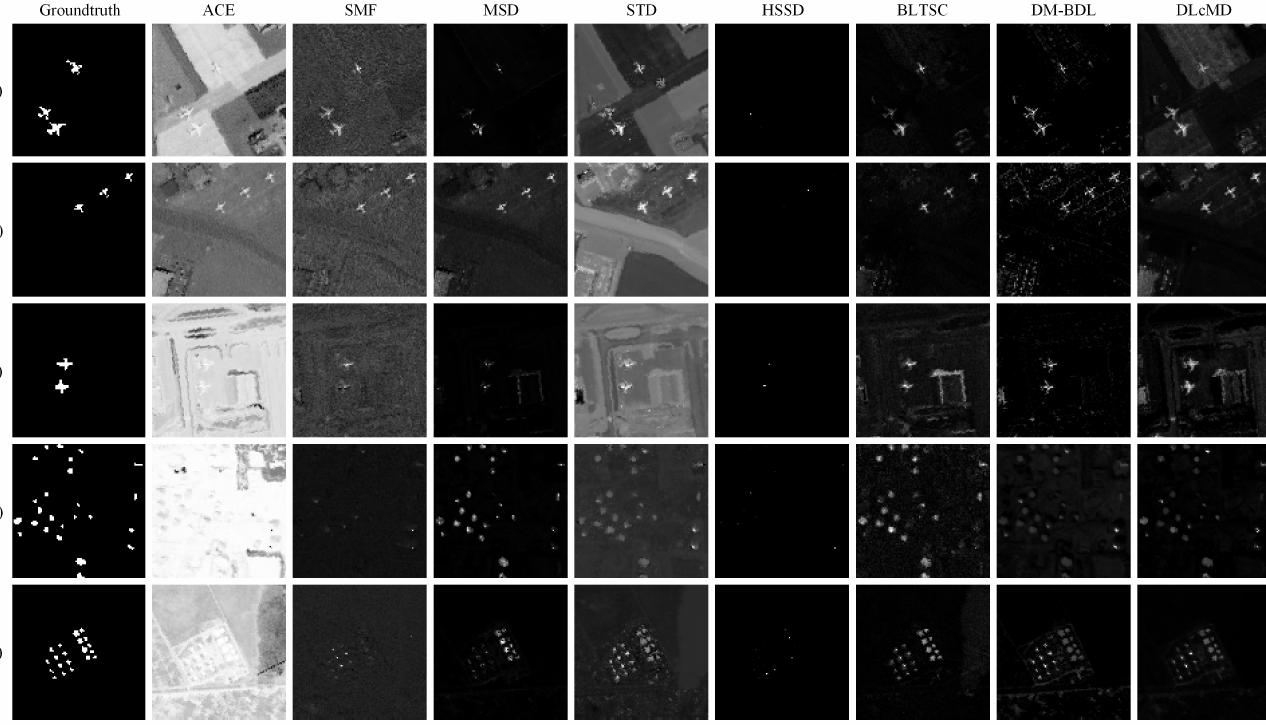
Figure 6. Hyperspectral target detection map on the five datasets. ( a ) San Diego-I. ( b ) San Diego-II. ( c ) Los Angeles-I. ( d ) Los Angeles-II. ( e ) Texas